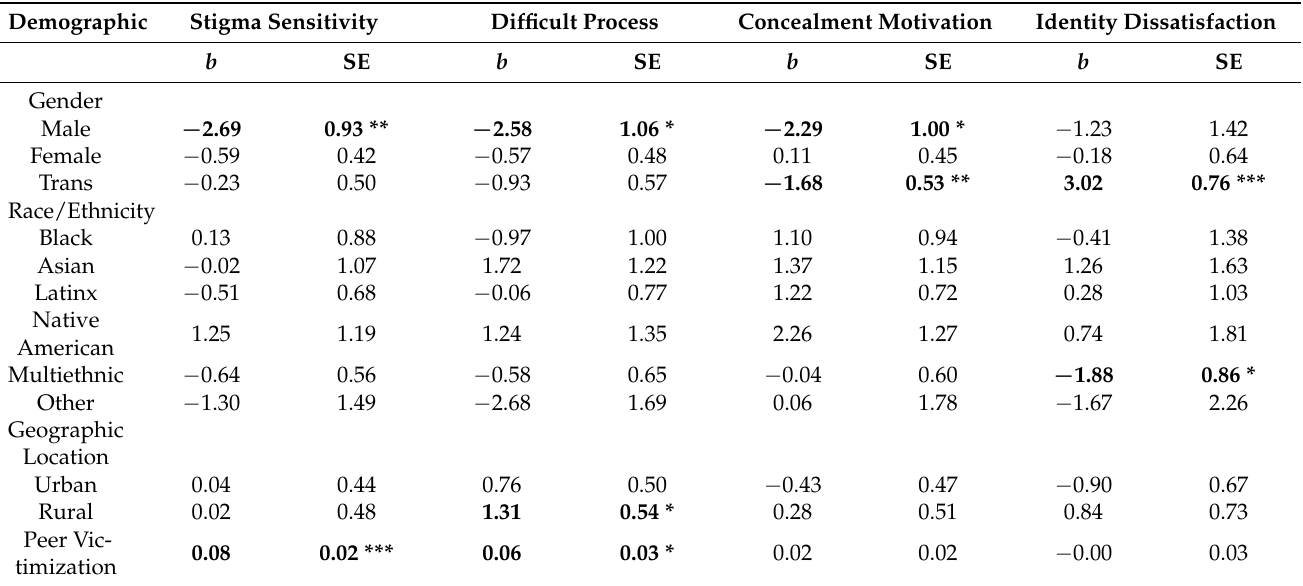
Table 3. Linear regression models estimating associations between peer victimization and LGBTQ+ identity